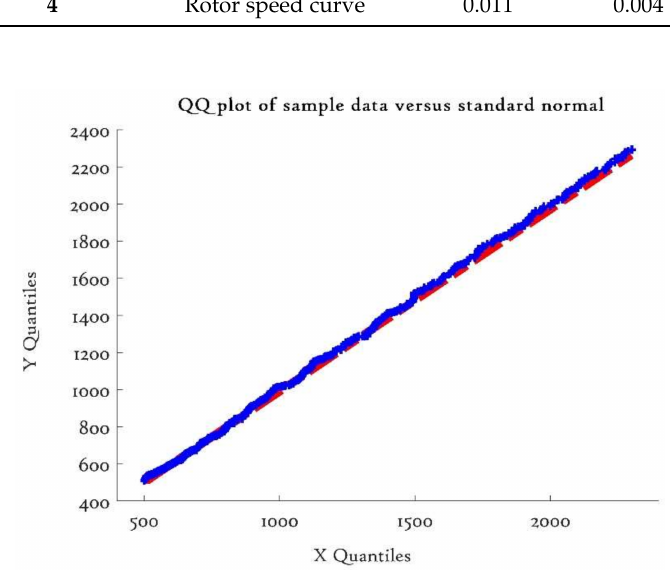
Figure 17. QQ plot for GP power curve.